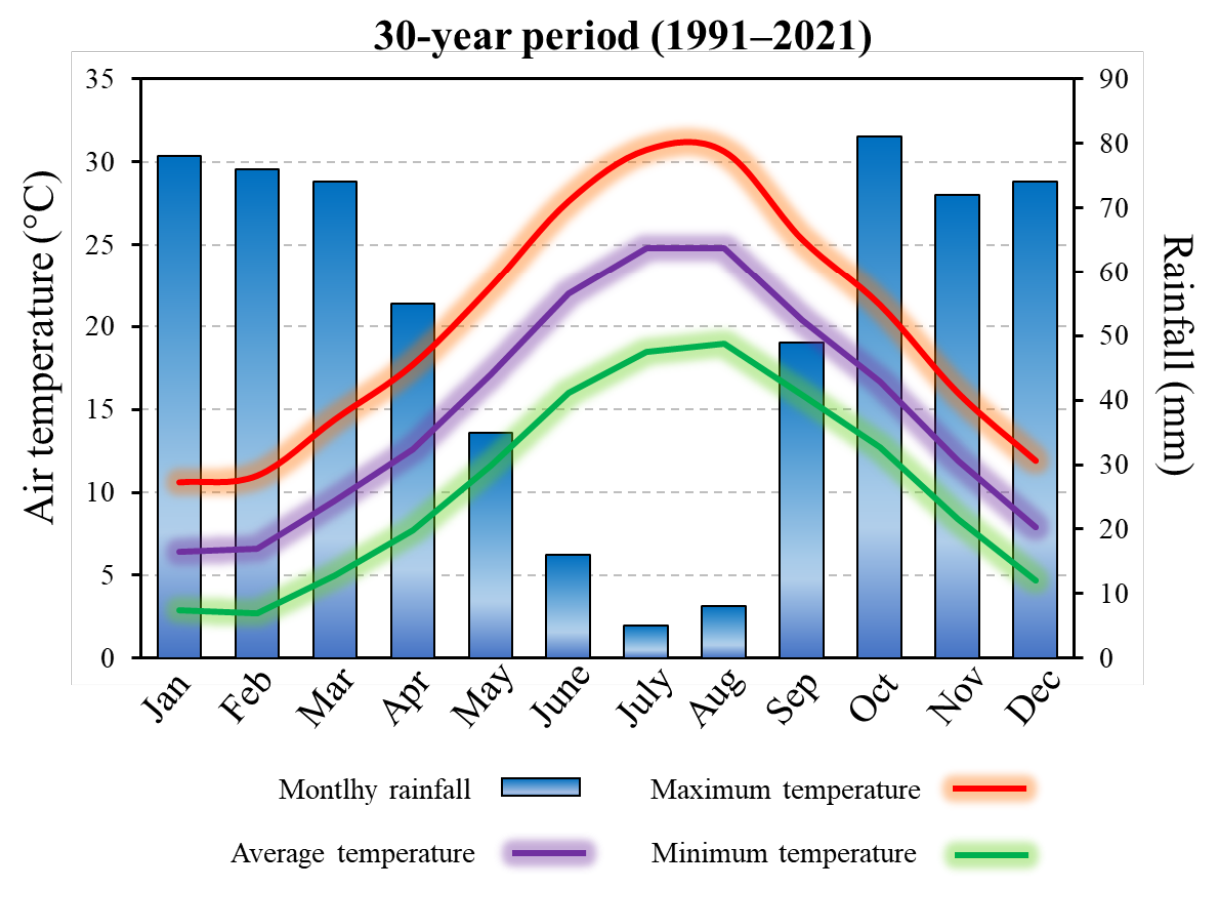
Figure 4. Long-term period of total monthly rainfall and monthly air temperatures (maximum, average and minimum) in the survey area (Central-Eastern Sicily, South Italy).